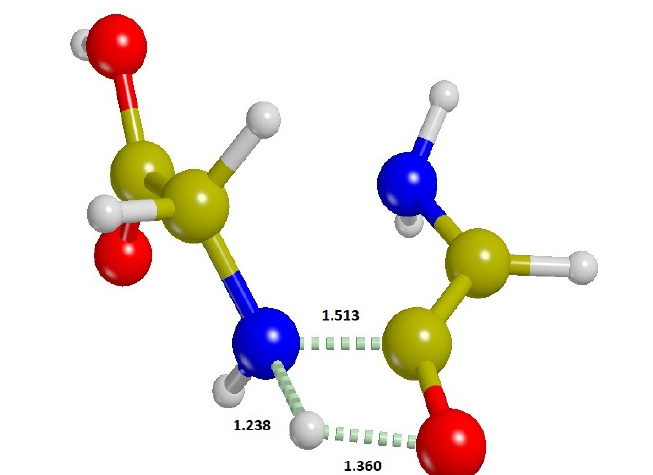
Figure 10. Transition structure for the addition of glycine to aminoketene with formation of GlyGly. The potential energy barrier at the B3LYP/6-31G(d,p) level of theory is 17.14 kcal mol − 1 . Geometries are fully optimized, and distances are in angstroms.